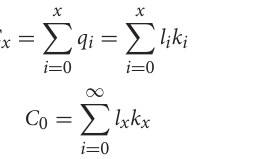
Life table of O. strigicollis under